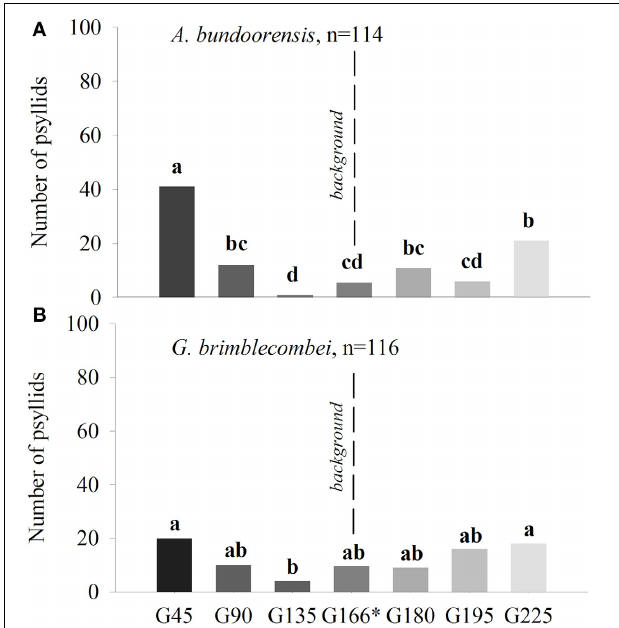
FIGURE 6 | Attraction of psyllids toward achromatic stimuli of (A) A. bundoorensis and (B) G. brimblecombei . ∗ Number of psyllids was normalized based upon the proportion of the circumference occupied by the background color in the arena.